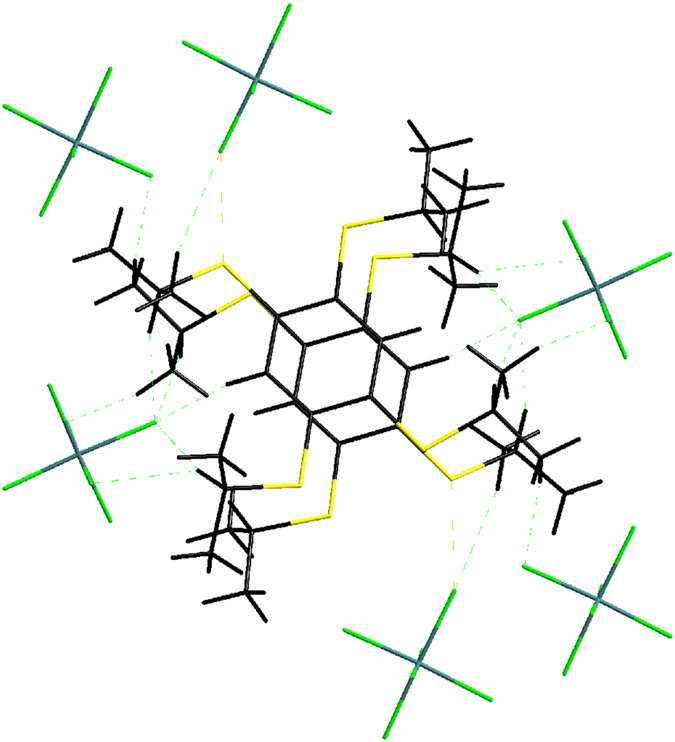
Crystal packing of .